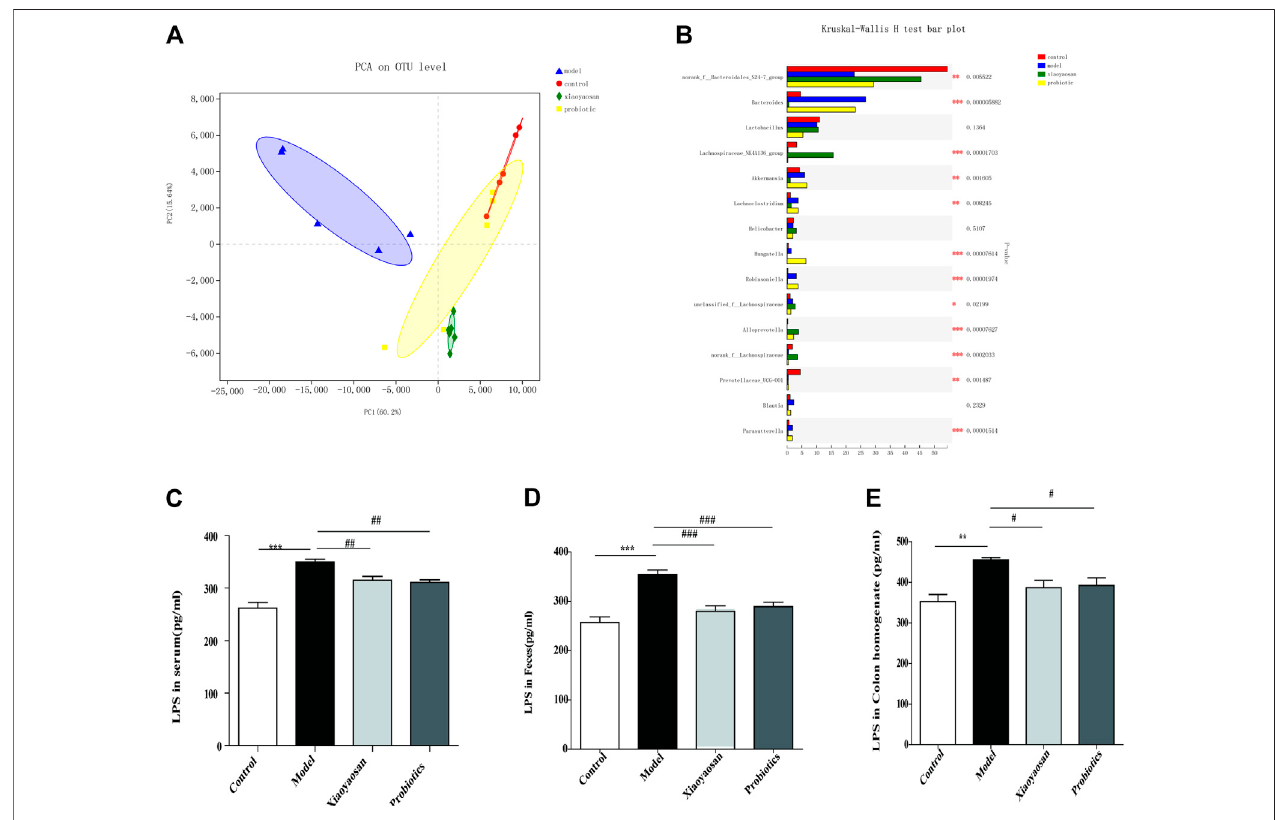
FIGURE 3 | Effect of XYS on gut microbiota and LPS Level of antibiotic-induced mice. (A) PCA principal component analysis. (B) Results of a completely randomized multi-sample rank sum test. (C) Effects of Xiaoyaosan on LPS Level of Serum. (D) Effectsof Xiaoyaosan on LPS Level of feces. (E) Effects ofXiaoyaosan on LPS Level of colon homogenate.